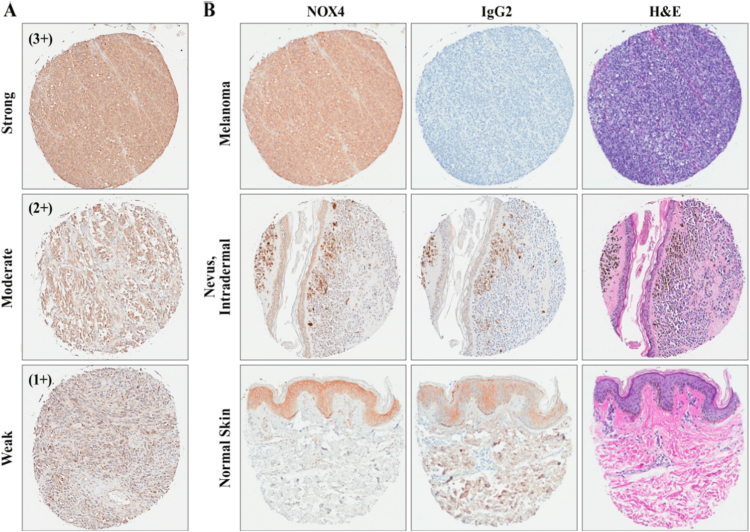
Immunohistochemical (IHC) staining of melanoma tissues demonstrating NOX4 expression. (A) Depiction of melanoma tissues across scoring intensities from weak (1+), moderate (2+), and strong (3+). (B) Tissues stained with NOX4 mAb (47-6), haemotoxylin and eosin (H&E), or normal rabbit isotype control (IgG2) across normal and malignant skin samples. All samples are digitally magnified at 10x.